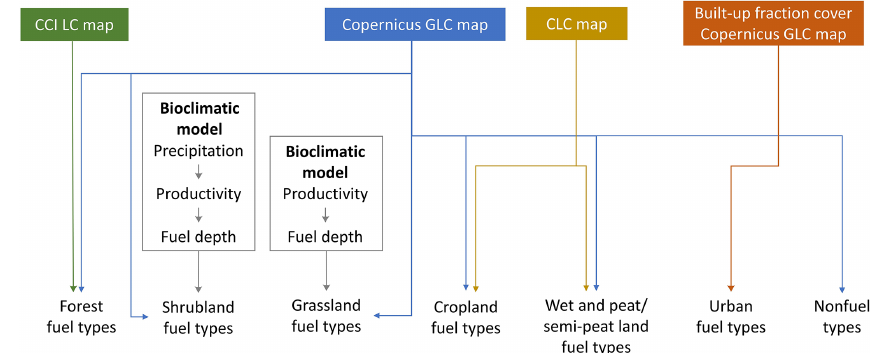
Figure 3. Methodology used to generate the European fuel map. The input sources are in the text.